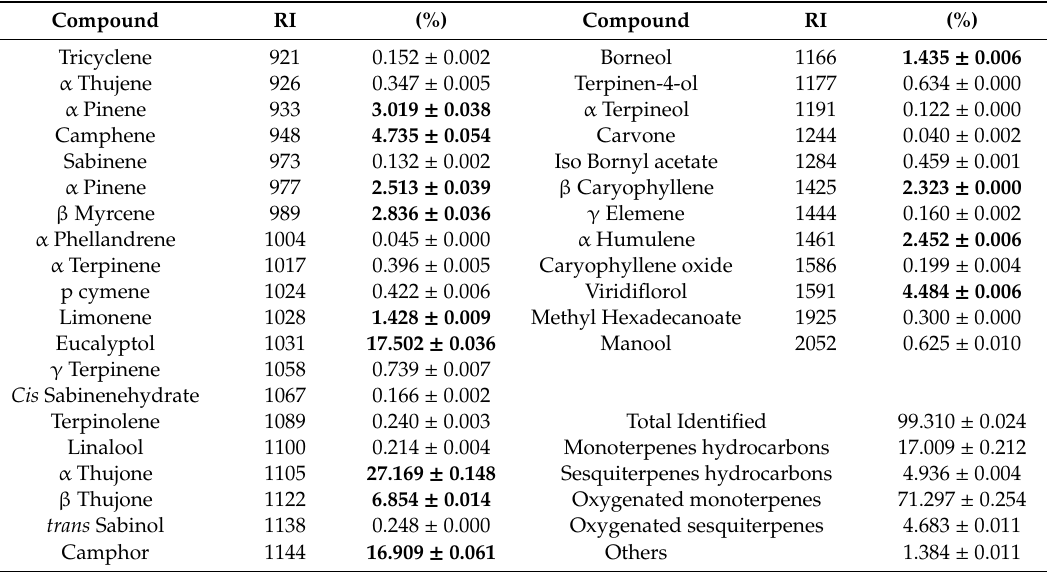
Table 1. Chemical composition (%) of essential oils of sage